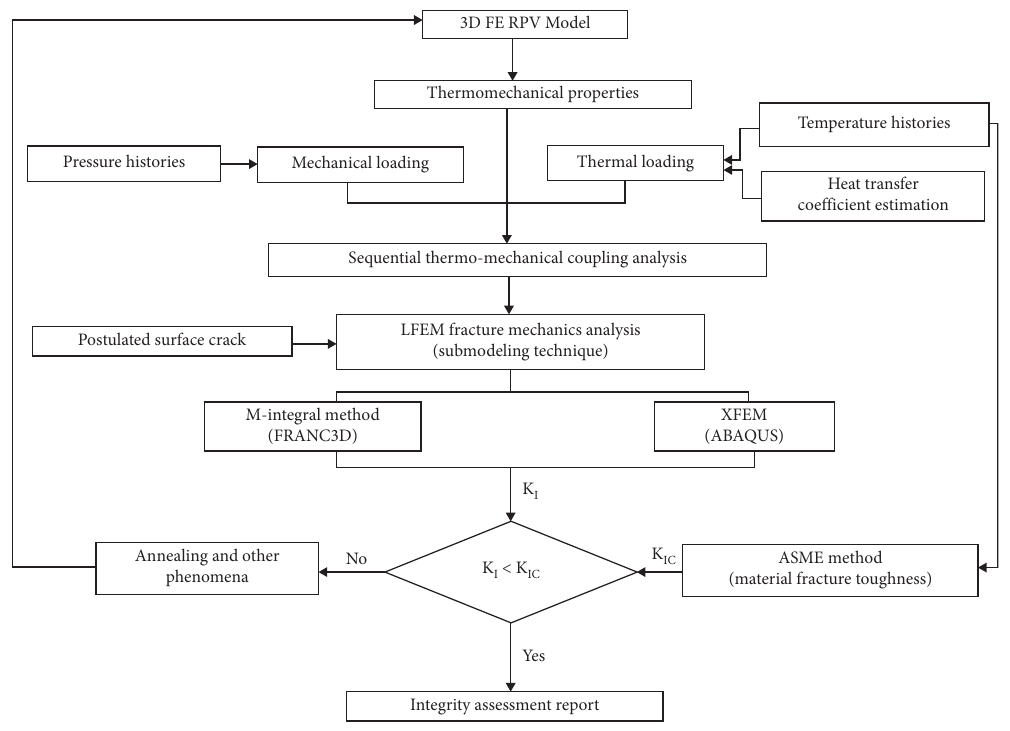
Figure 4: Flow chart of the structural integrity assessment of RPV subjected to AOO PTS loads.